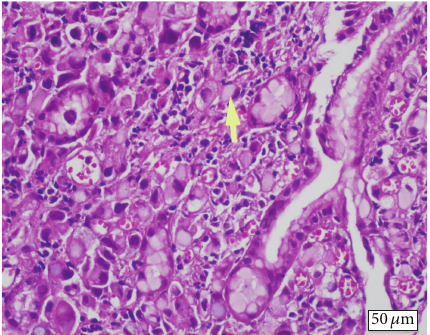
Figure 1: Primary signet-ring cell (arrow) carcinoma of the stomach (H&E, × 20).